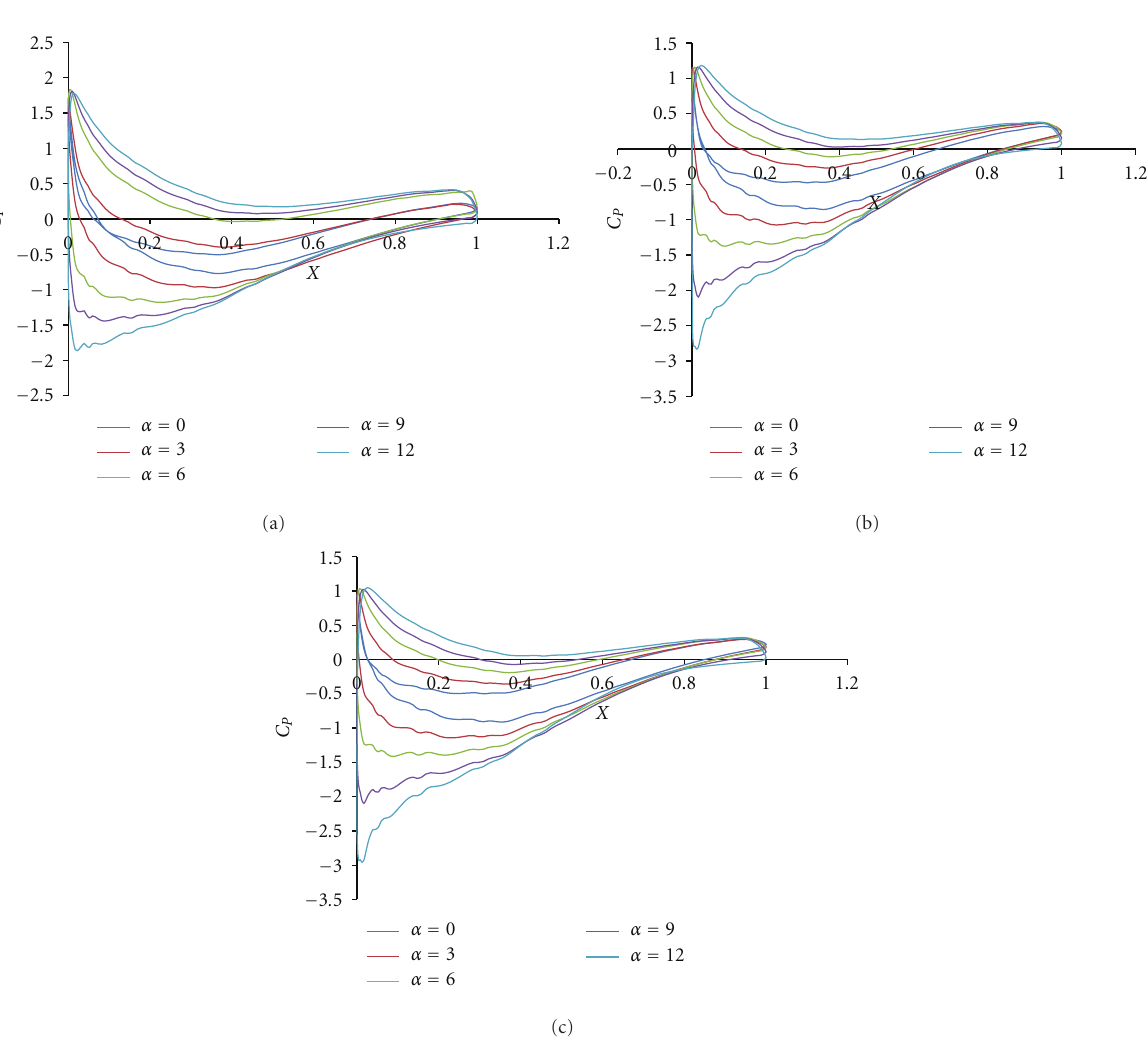
Figure 7: (a) C p distribution of NACA 63-421 airfoil at Re = 68,459. (b) C p distribution of NACA 63-421 airfoil at Re = 479,210. (c) C p distribution of NACA 63-421 airfoil at Re =